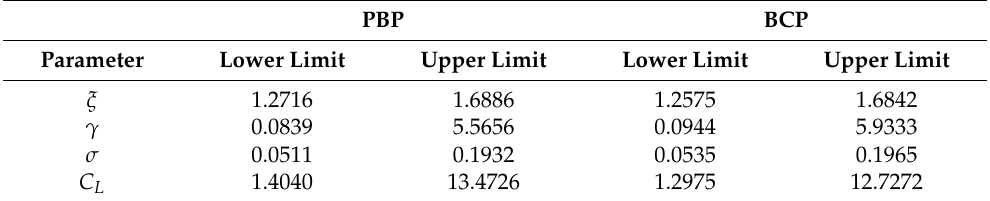
Table 2. The 95% bootstrap confidence intervals based on the original sample with n = 185